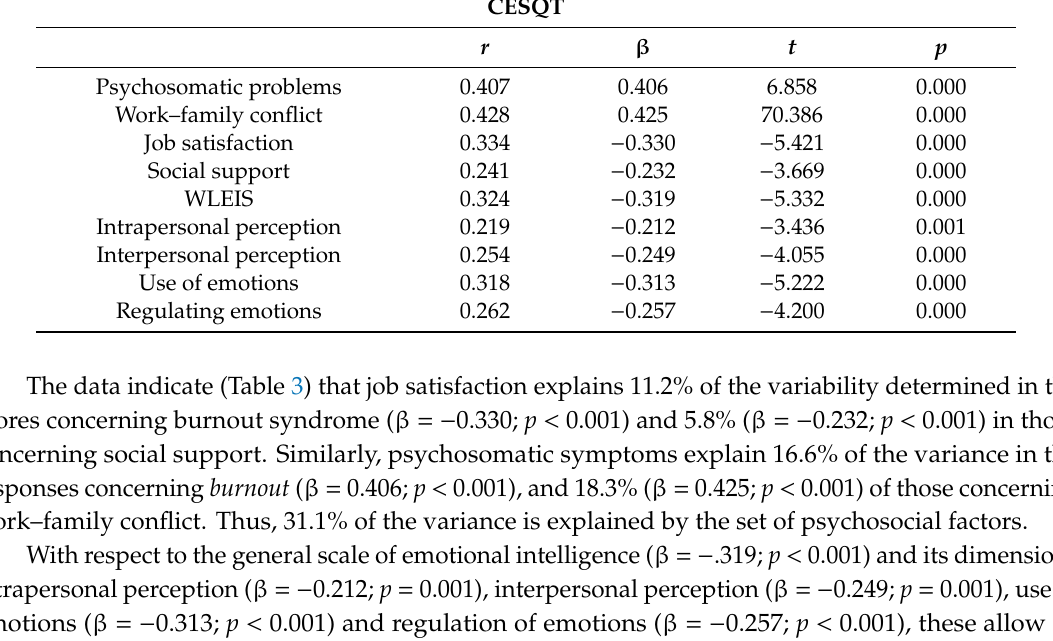
Table 3. Linear regression analysis of the Questionnaire to Evaluate the Burnout Syndrome at Work (CESQT) with respect to the psychosocial factors and emotional intelligence. CESQT r